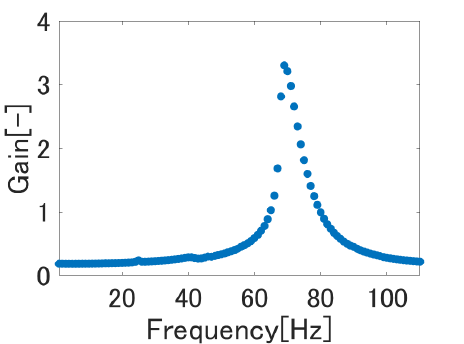
Figure 4. Gain-frequency characteristics of the target bimorph actuator.